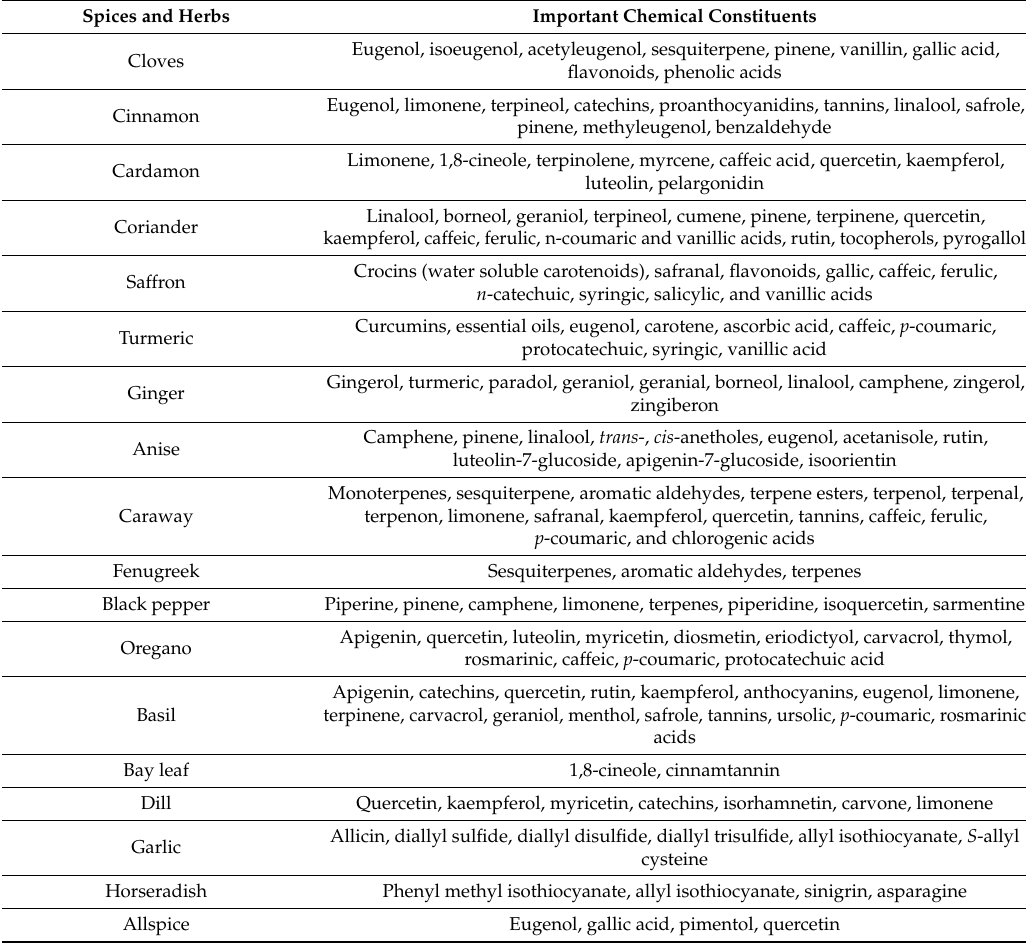
Table 1. Chemical composition of spices (seasonings) and culinary herbs